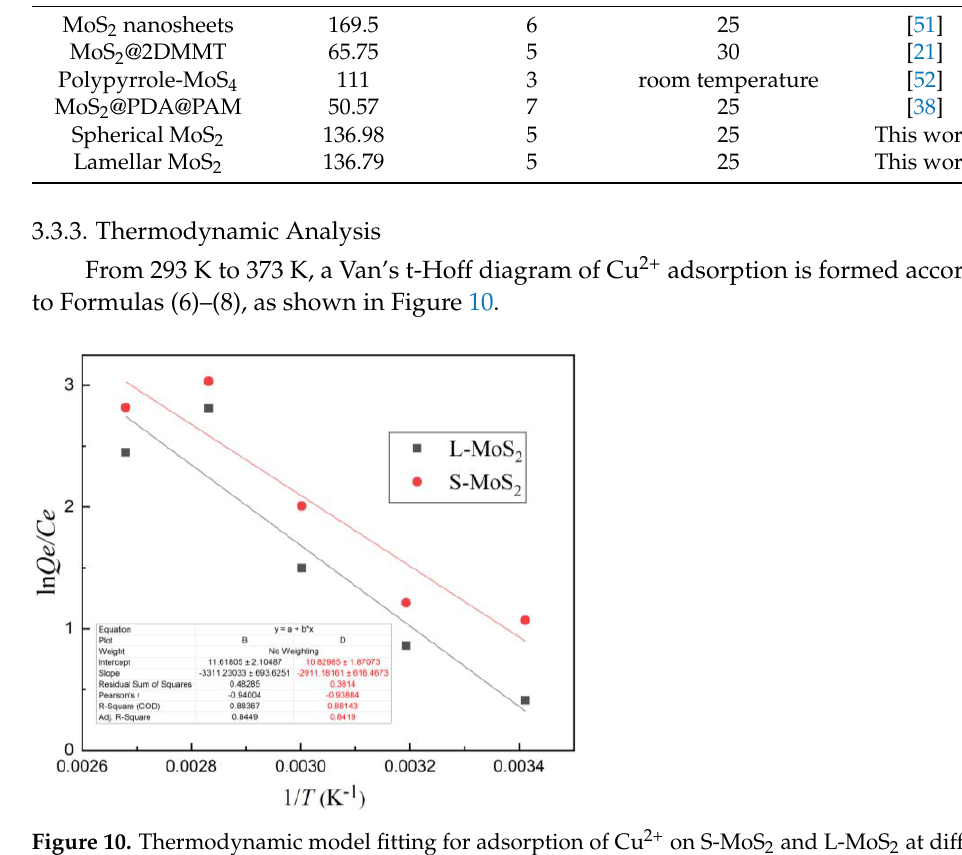
Experimental Conditions pH Temperature ( ◦ C)